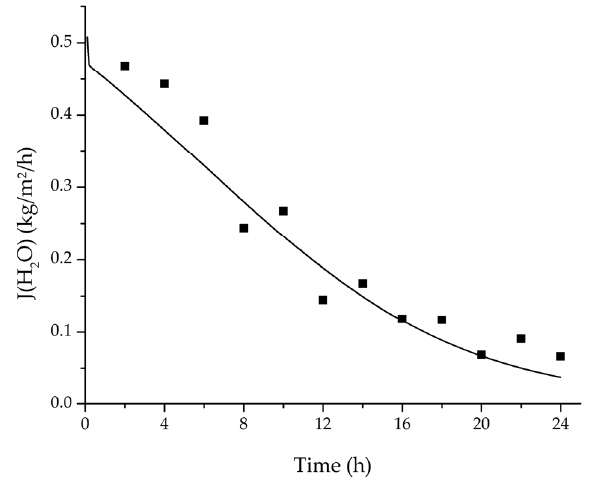
Figure 20. Comparison of the measured and simulated water flux for the pervaporation plant.